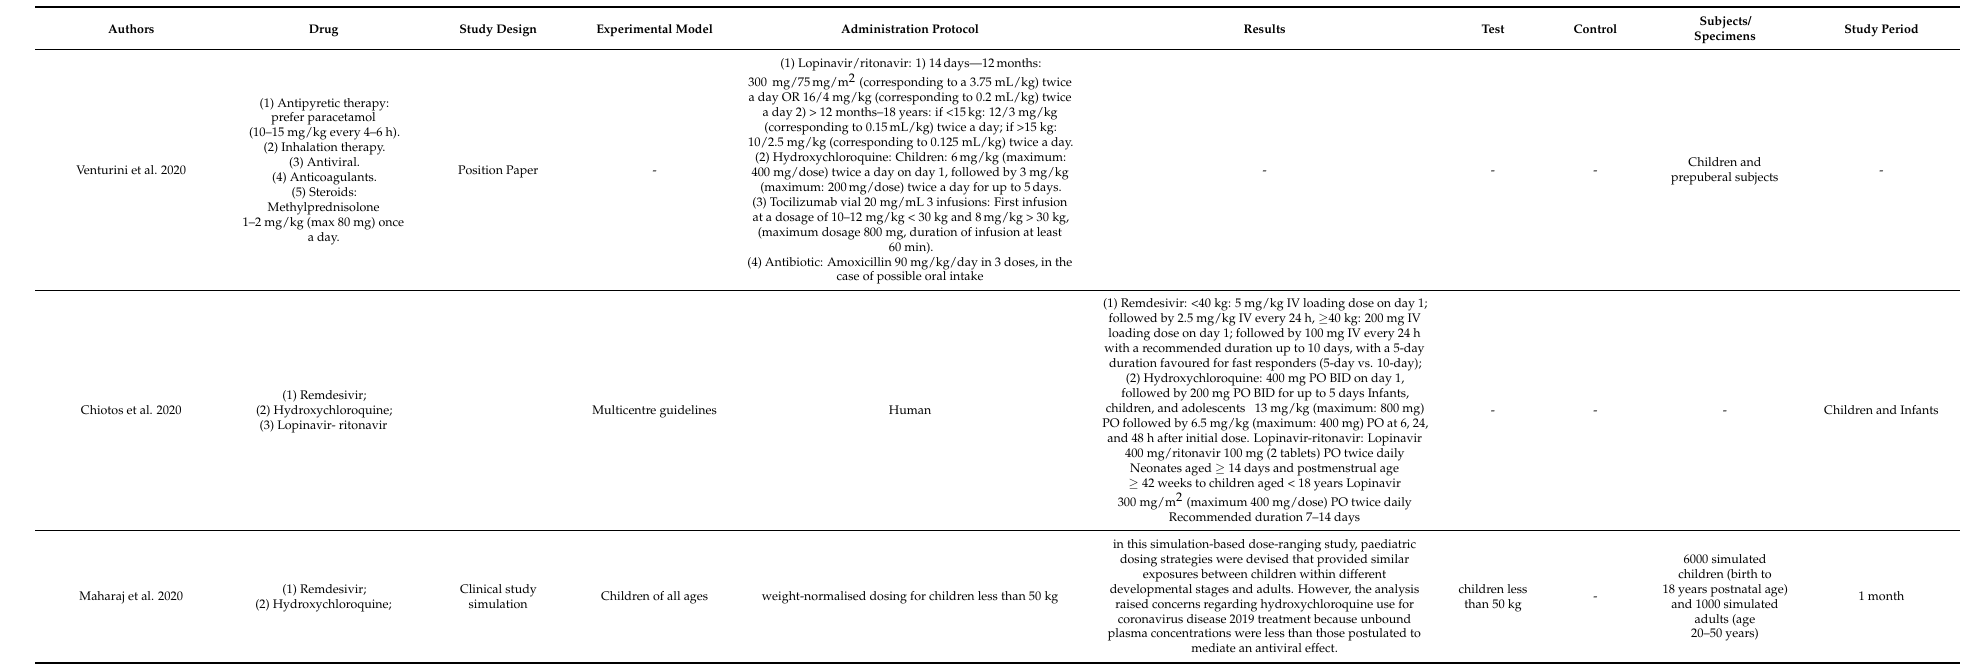
Table 2. Summary of COVID-19